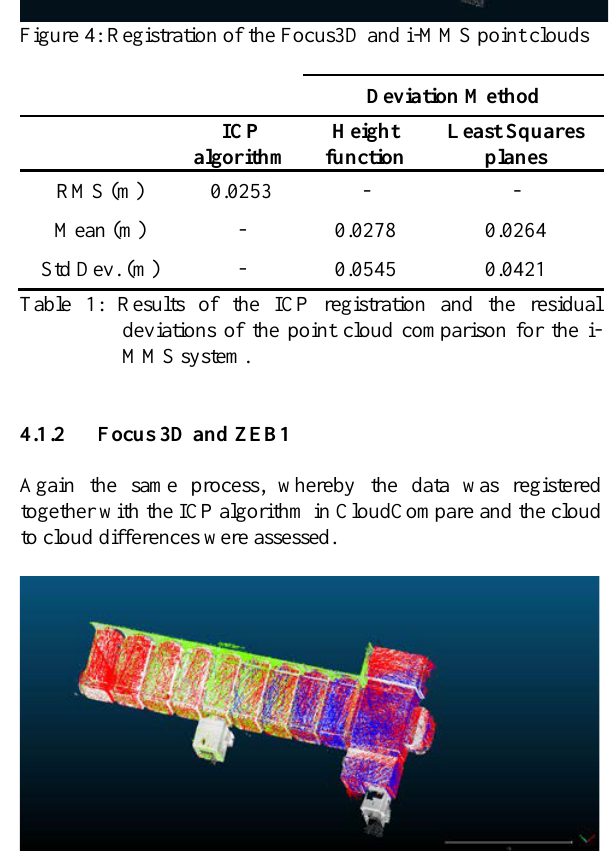
Figure 6: Registration of the Focus3D and ZEB1 point clouds